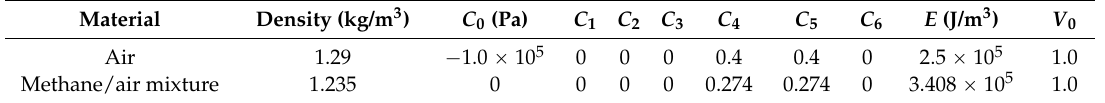
Table 2. Parameters of linear polynomial equation of